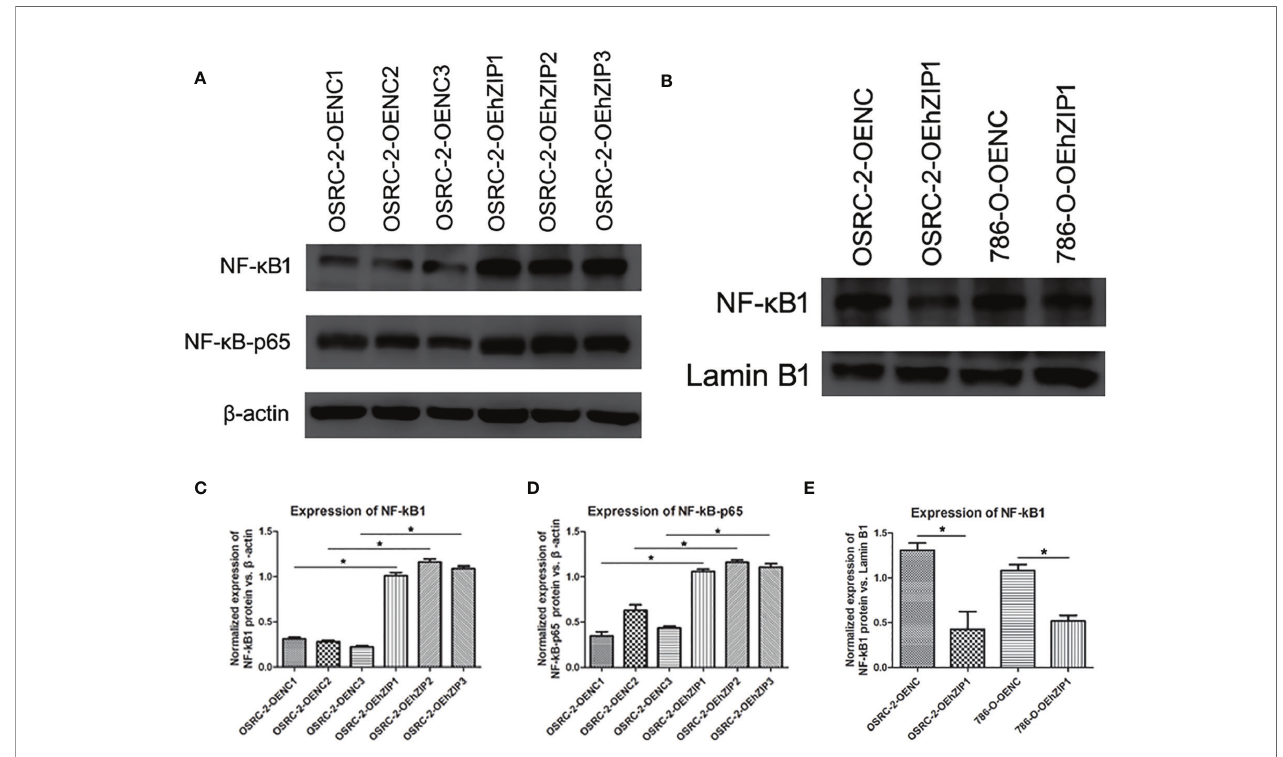
FIGURE 7 | hZIP1affected NF-kB pathway. (A, C, D) Western blot results demonstrated that NF-kB1 and NF-kB-p65 expression signi fi cantly increased after expression of hZIP1 ( “ * ” represented P <0.05). (B, E) Additionally, less NF-kB1 moved into the cell nucleus was detected in OSRC-2-OEhZIP1 cells and 786-O- OEhZIP1 cells ( “ * ” represented P